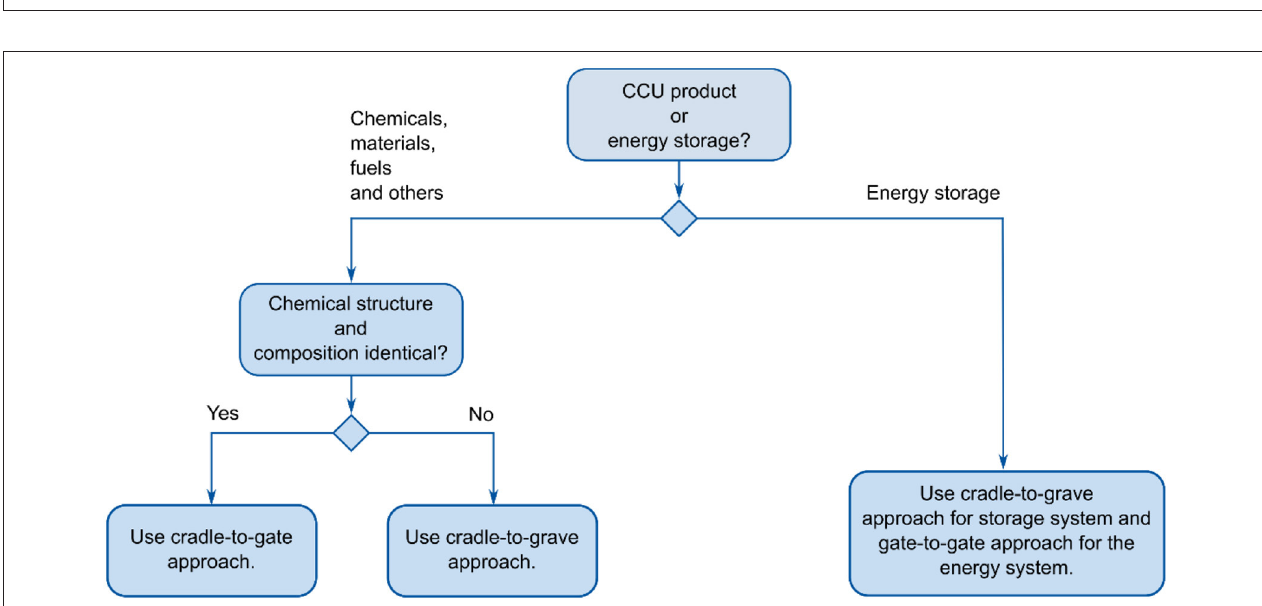
FIGURE 5 | Decision tree for the selection of system boundaries.